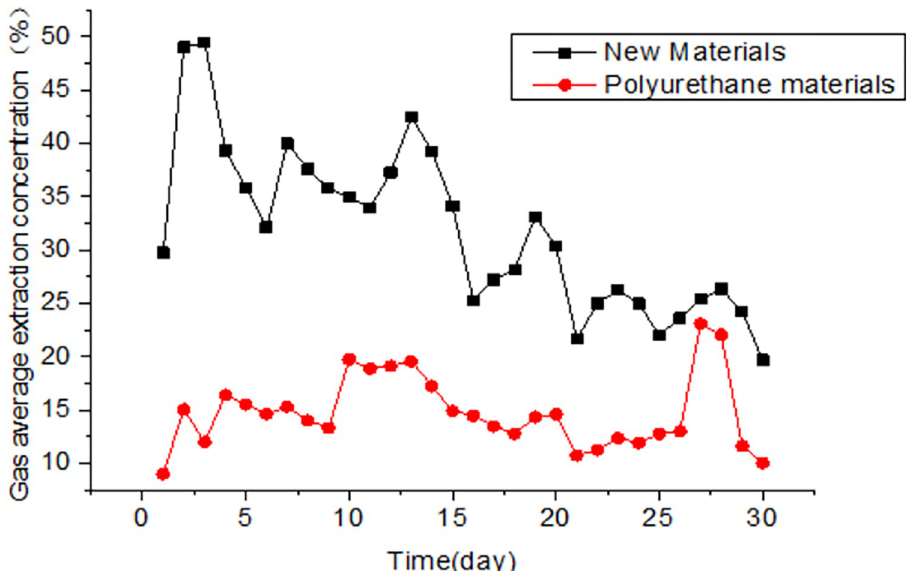
Fig 18. Comparison of the gas pressure using conventional polyurethane sealing material and the novel dual- liquid sealing material.